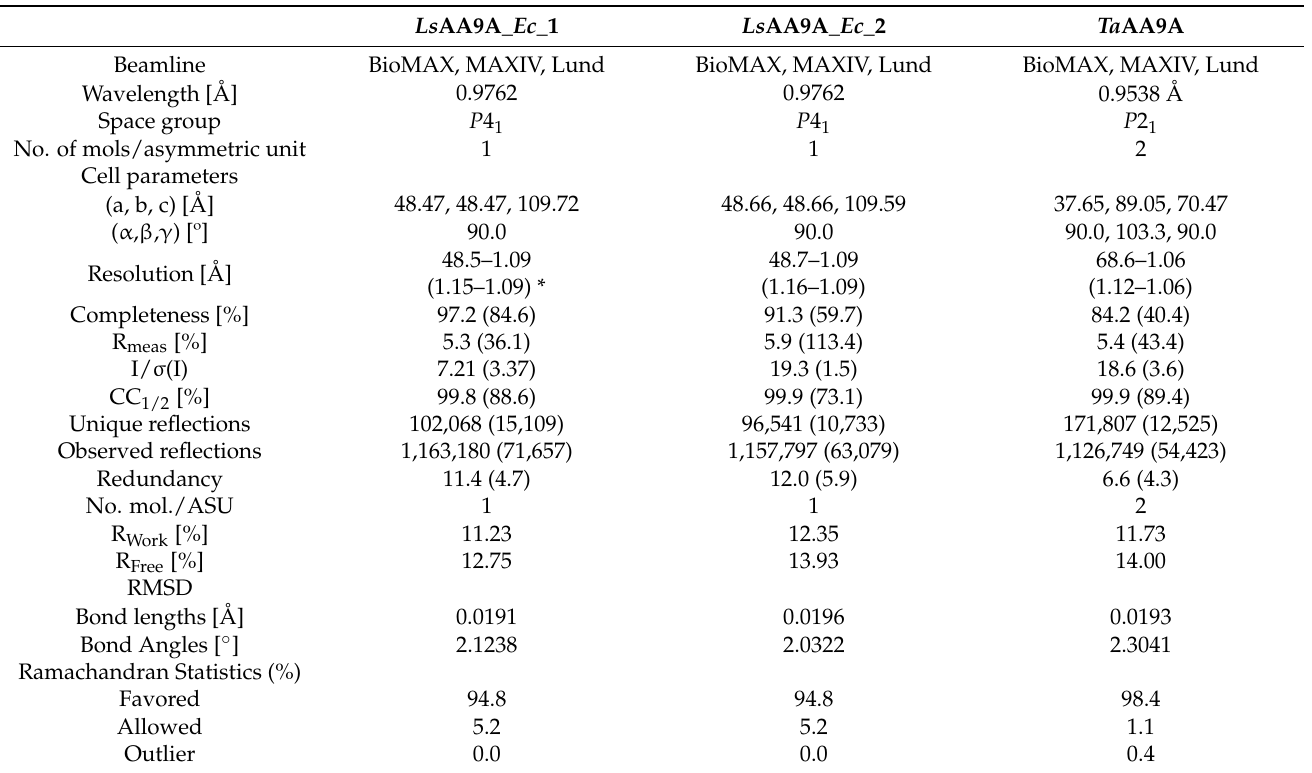
Table 1. Data Collection and Refinement Statistics for the three high resolution structures